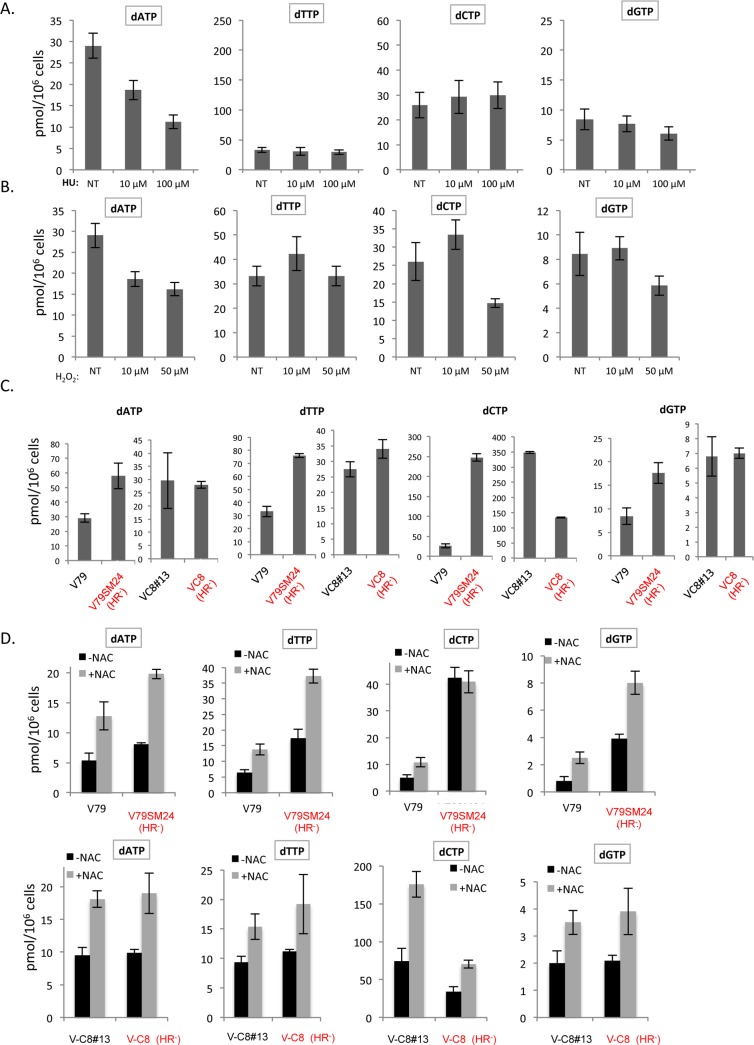
dNTP pool measurements.A/ dNTP concentrations after exposure to different doses of HU. B/ dNTP concentrations after exposure to H2O2. C/ dNTP concentrations in unchallenged WT and HR- cells. D/ Impact of NAC (2 mM, 48 h) on dNTP concentrations in WT and HR- cells. The experiments were performed in triplicate. NT: not treated.